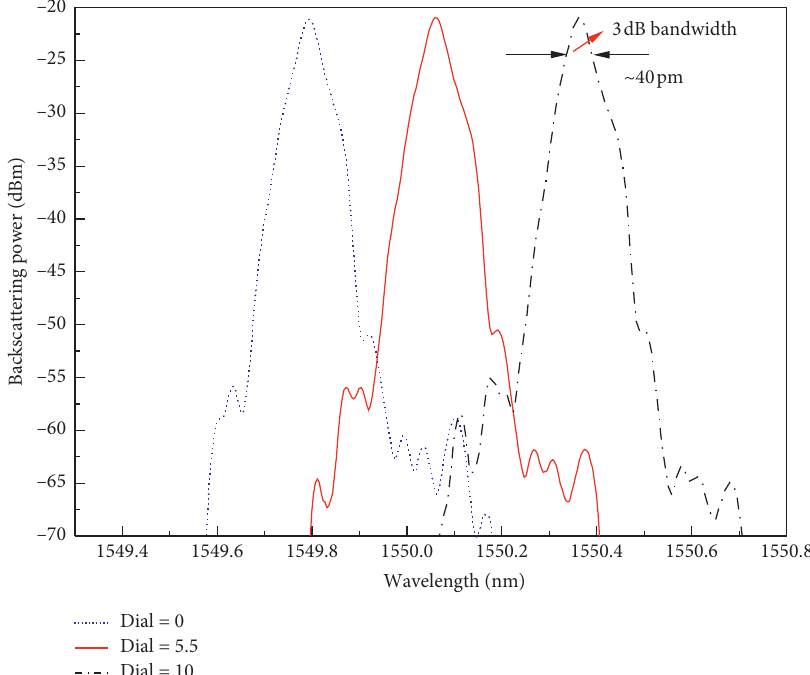
Figure 3: Observed spectral characteristics of the thermally adjustable narrowband FBG2 filter as the dialing value is 0, 5.5, and 10, respectively.